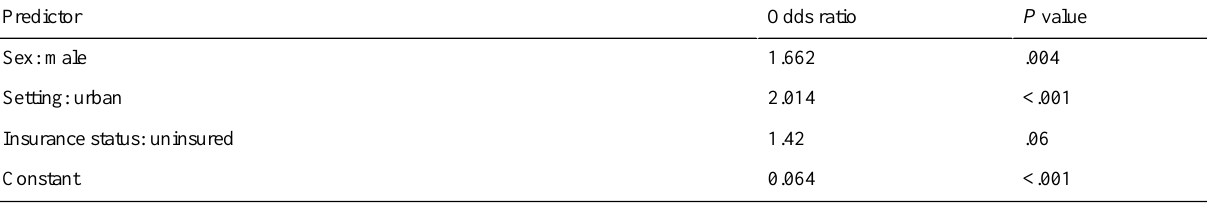
Table 2. Odds ratio and significance ( P value) of the demographic predictors a .